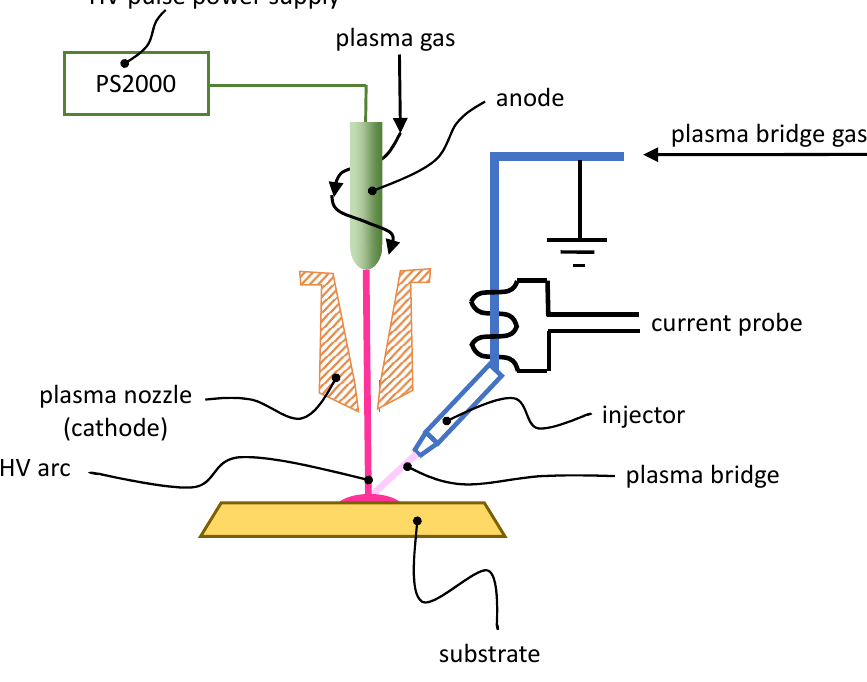
Figure 1. Setup for plasma bridge